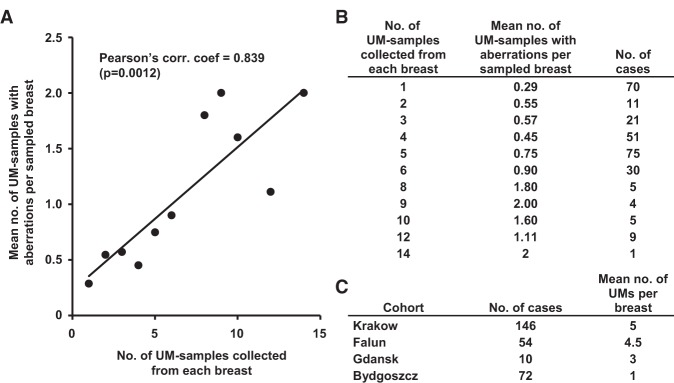
A larger number of UM samples studied per breast increases the likelihood of finding genetically aberrant UM tissue. (A) The number of UMs sampled per patient is positively correlated with the mean number of UMs displaying an aberrant genetic profile among all 282 studied cases of breast cancer. (B) Table showing the number of cases that were used for the plot in A and that were the basis for calculation of the correlation coefficient. (C) Table showing the number of cases and the mean number of UMs that were studied from each of the four participating oncology centers.